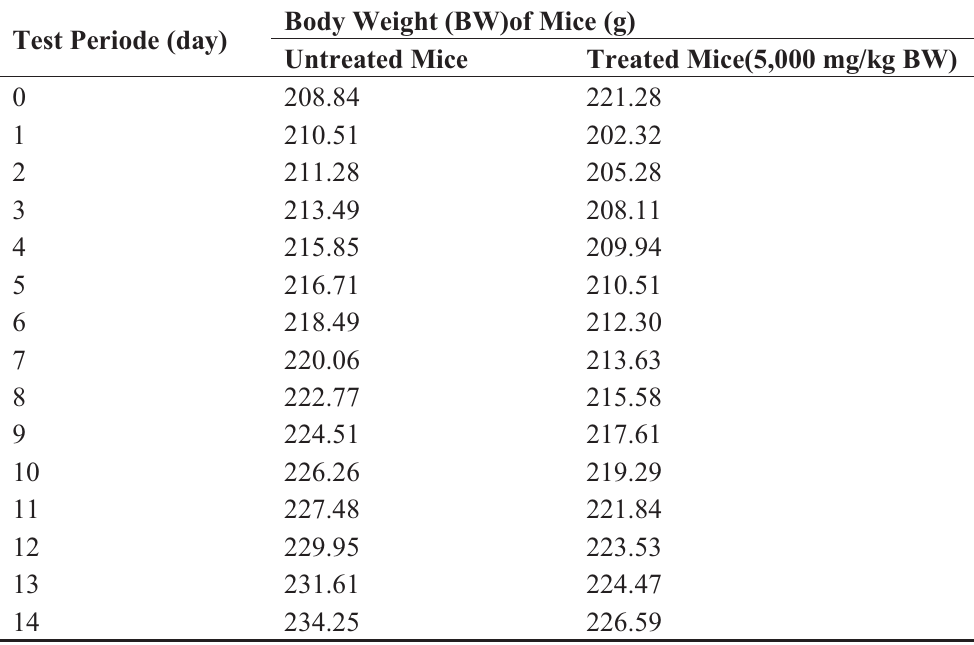
Table 3. Average body weight groups of Sprague Dawley mice receiving treatment of acute oral toxicity, after treated by C-C organic compound solution with a dose of 5,000